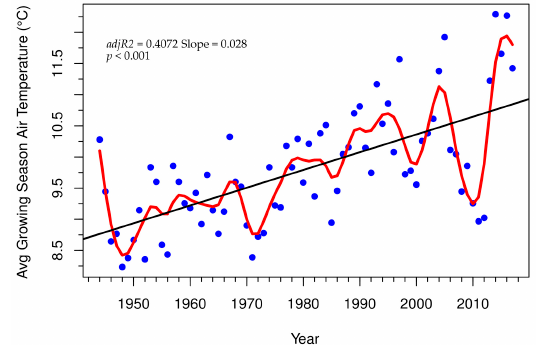
Figure 1. Change in average growing season air temperature (°C) (May–September) between 1944 and 2017 at Homer, Alaska airport on the Kenai Peninsula. Dots are the average growing season air temperature, and the curved line is the mean of growing season air temperatures. Temperature has risen an average of 0.03 °C per year since 1944 ( p < 0.001).